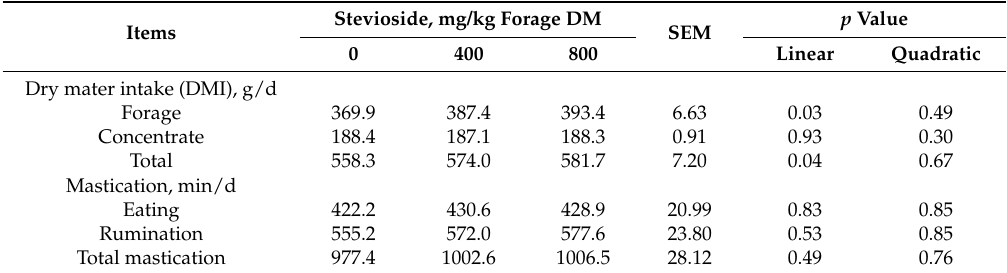
Table 2. Effects of stevioside on feed intake and mastication of goats